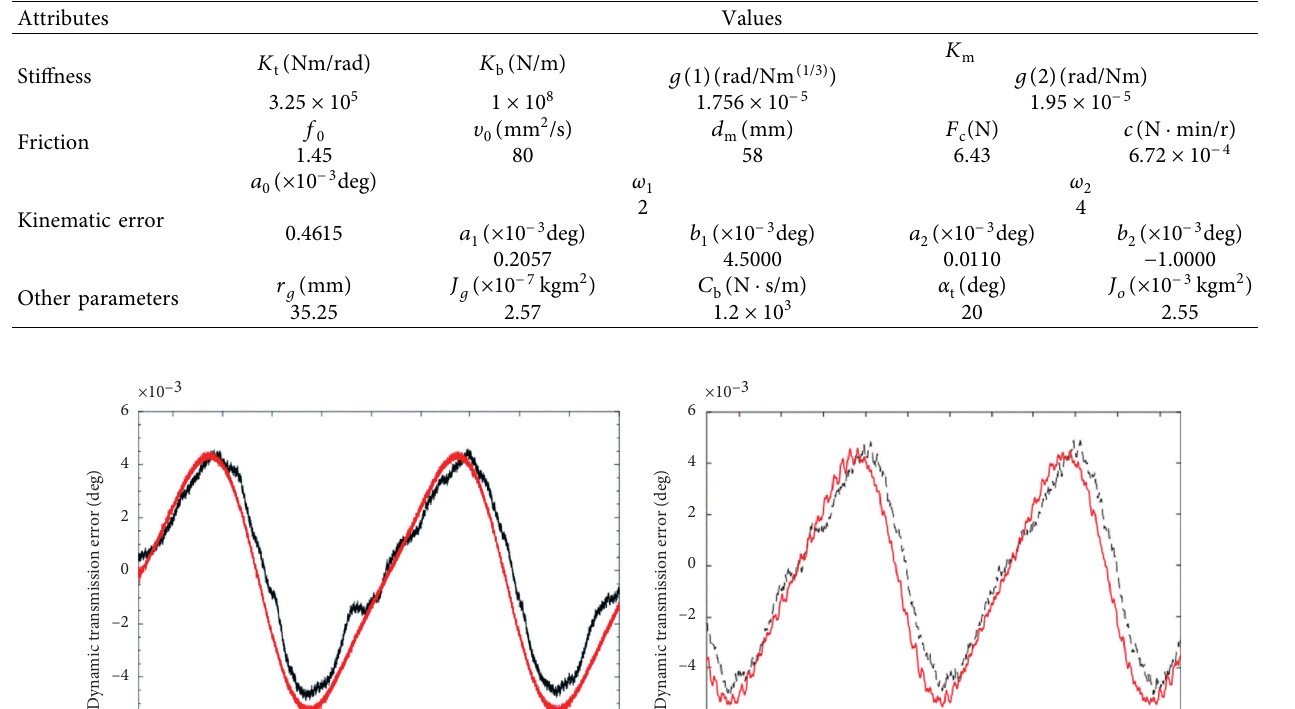
Table 1: Parameters used in the model simulation.